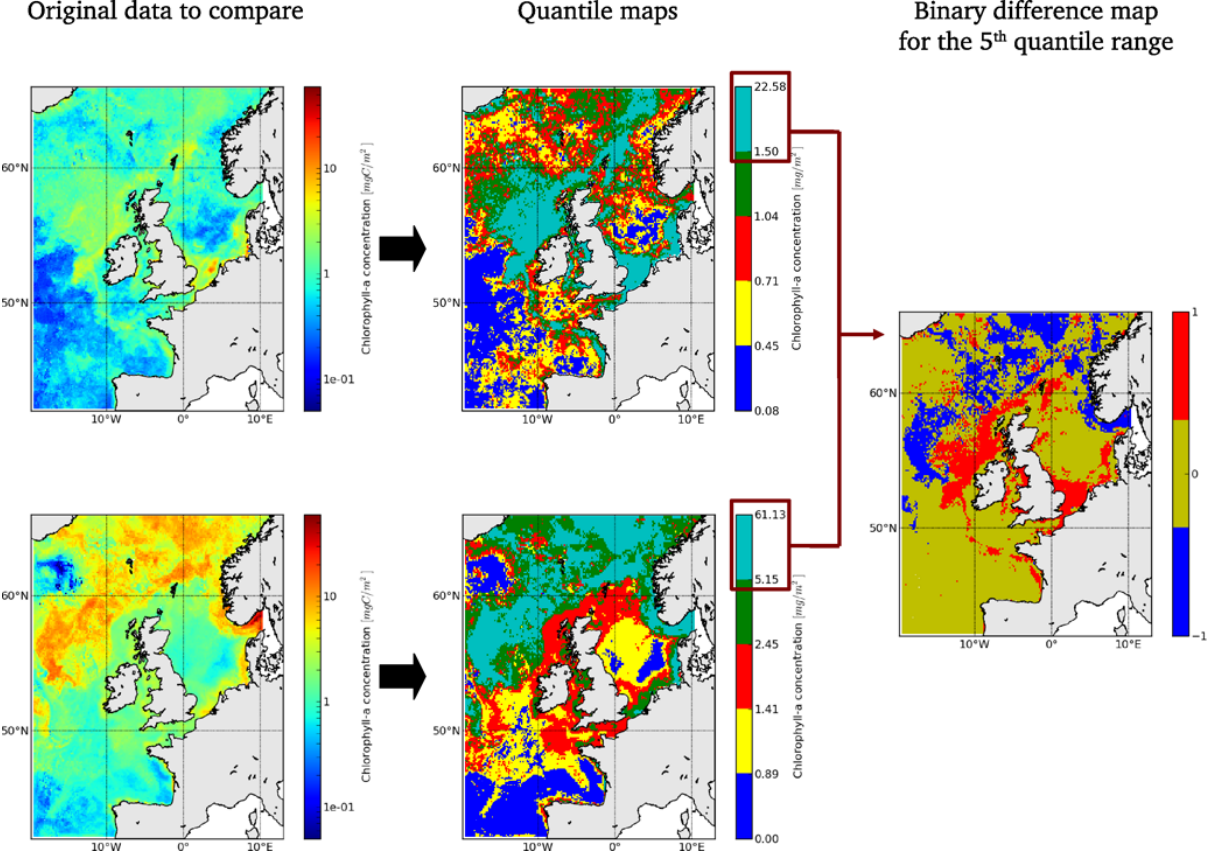
Fig. 1. Binary difference map creation. On the left: re-gridded satellite (top) and model (bottom) monthly fields of surface concentration of chlorophyll- a for May 2004. In the centre: quantile maps of the same fields (top, satellite; bottom model). On the right: binary difference map for the uppermost quantile